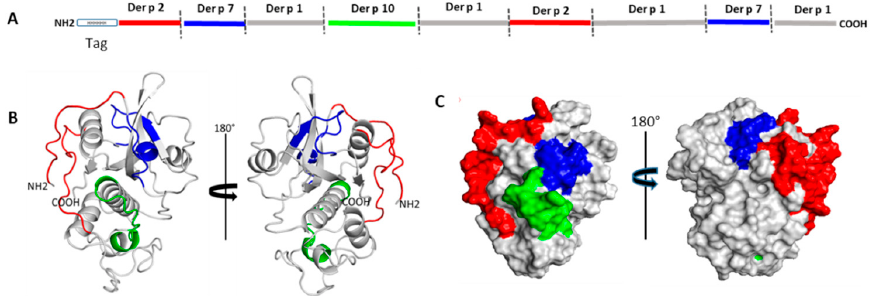
Figure 2. Schematic representation of DPx4 structure. ( A ). Order of segments in the DPx4 primary structure. ( B ) Cartoon representation, each segment is colored in the three-dimensional (3D) model in accordance to the antigenic segment defined above. ( C ) Surface color representation of the allergen segments included in the structure.